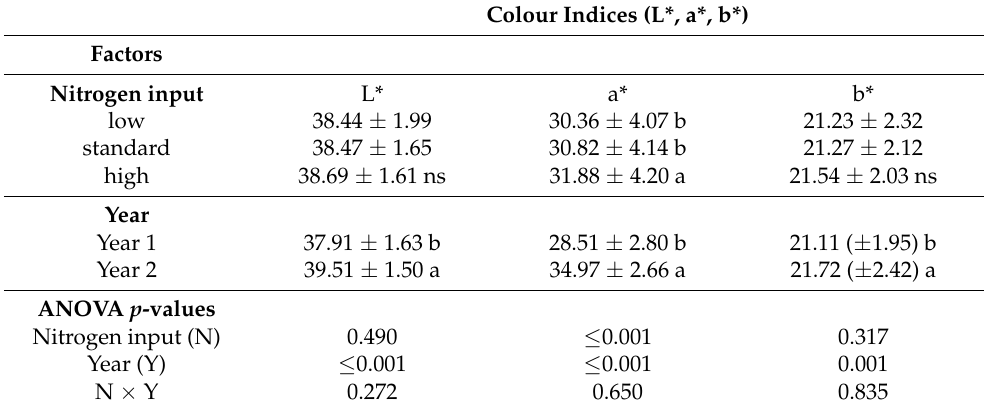
Table 3. Analysis of variance (ANOVA) for the colour indices (L*, a*, b*) in Years 1 and 2.